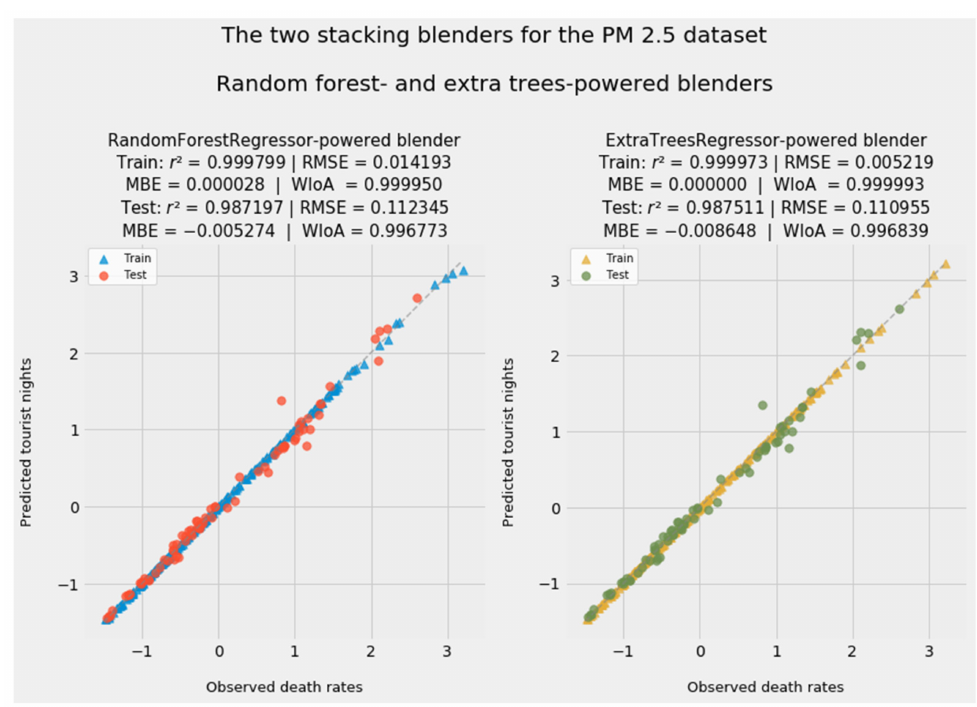
Figure 5. Predictions from stacking generalization, with alternative machine learning models (ran- dom forest versus extra trees) in level